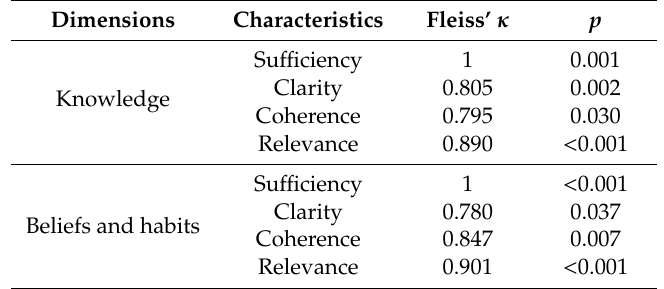
Table 6. Fleiss’ κ and statistical significance of the characteristics of the original instrument.